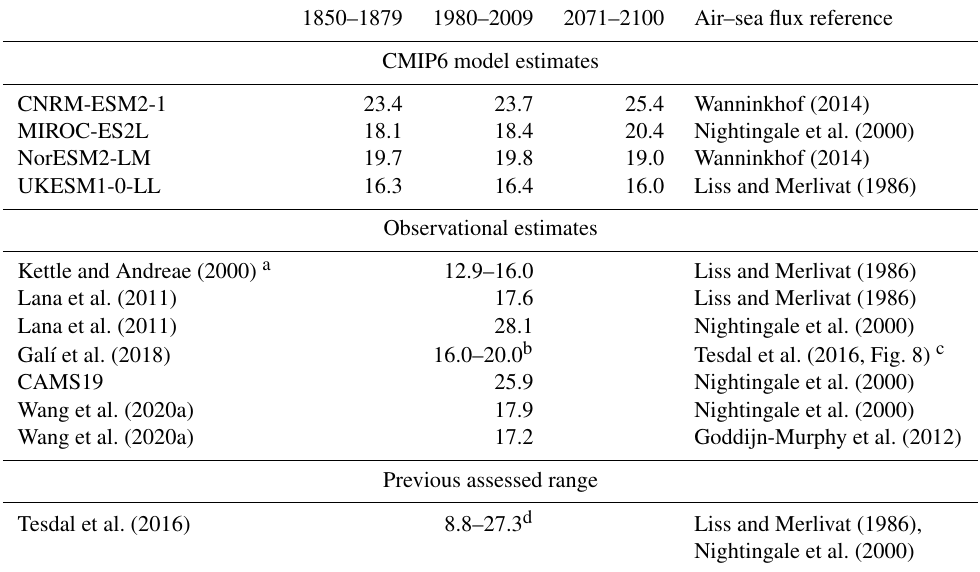
Table 6. Global mean DMS emissions (TgSyr − 1 ) of the four CMIP6 models over different 30-year periods. Emission totals of current estimations available in literature, displayed in 10 ◦ latitudinal bands in Fig. 7, are also